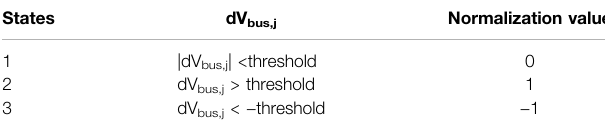
TABLE 3 | Normalization of emergency mode.